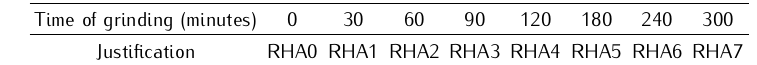
Table 2. Designation of rice husk ash with different grinding.